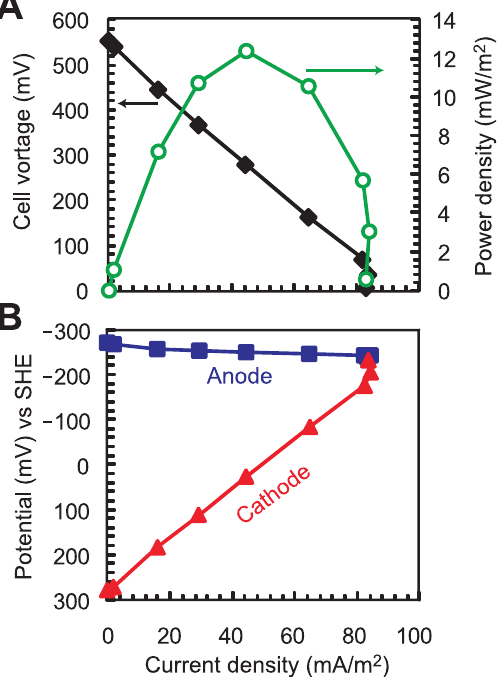
Figure 3. Power curve and polarization curves in the primary clarifier effluent-fed MFC. Power curve (A) and anodic and cathodic polarization (B) measured from the MFC after stable current production was observed on day 32. Anode potential (solid square), cathode potential (solid triangle), and cell voltages (solid diamond) were measured at various external resistances and plotted versus current density normalized to the projected anode surface area. Reactor power performance is represented by power density per anode surface area (open circle).